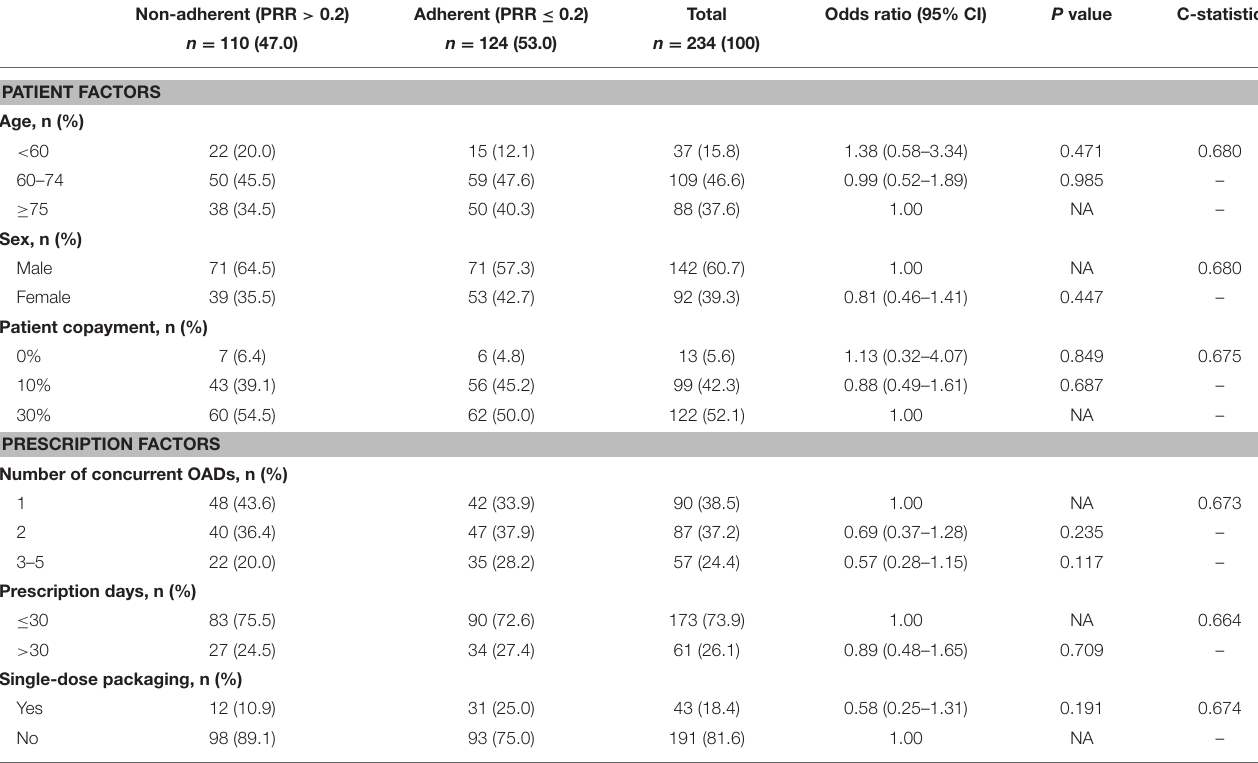
TABLE 3 | Factors contributing to non-adherence for OADs.